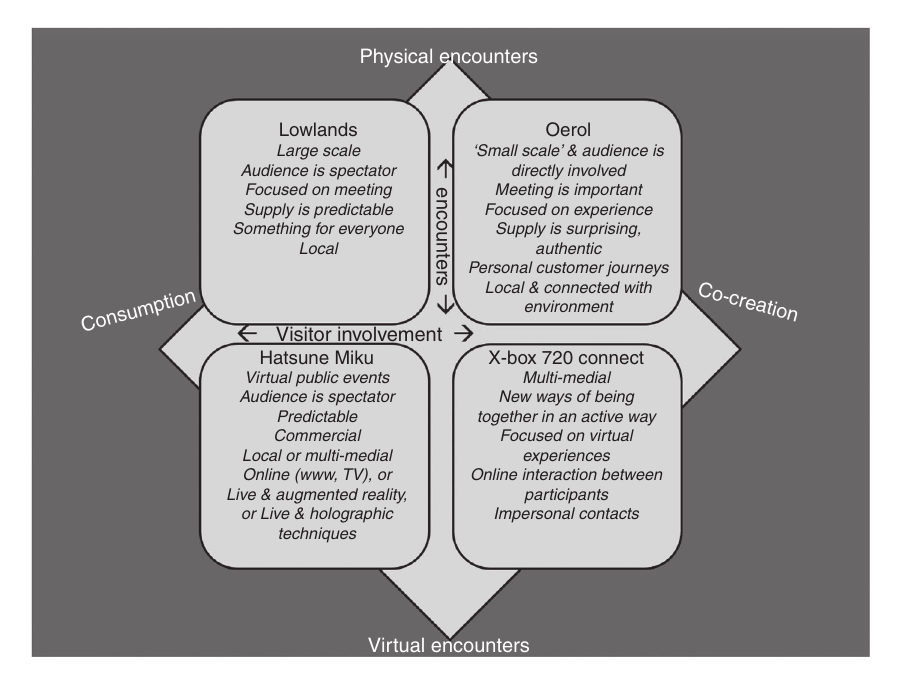
Figure 2 Future scenarios for